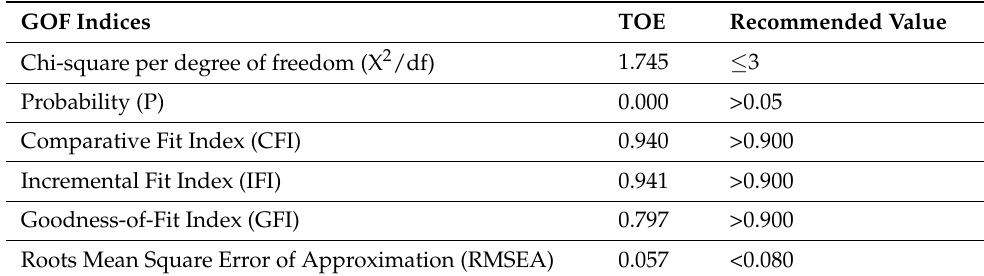
Table 1. Goodness-of-Fit for measurement